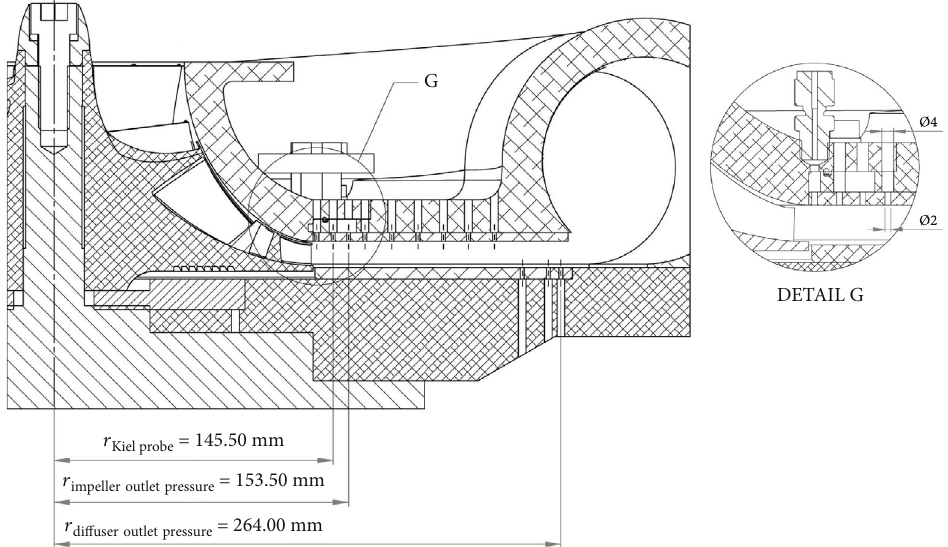
Figure 2: Measurement locations of total pressure and temperature (Kiel probe) at the impeller outlet and static pressure at the impeller and di ff user outlets. Detail G shows the dimensions of the static pressure